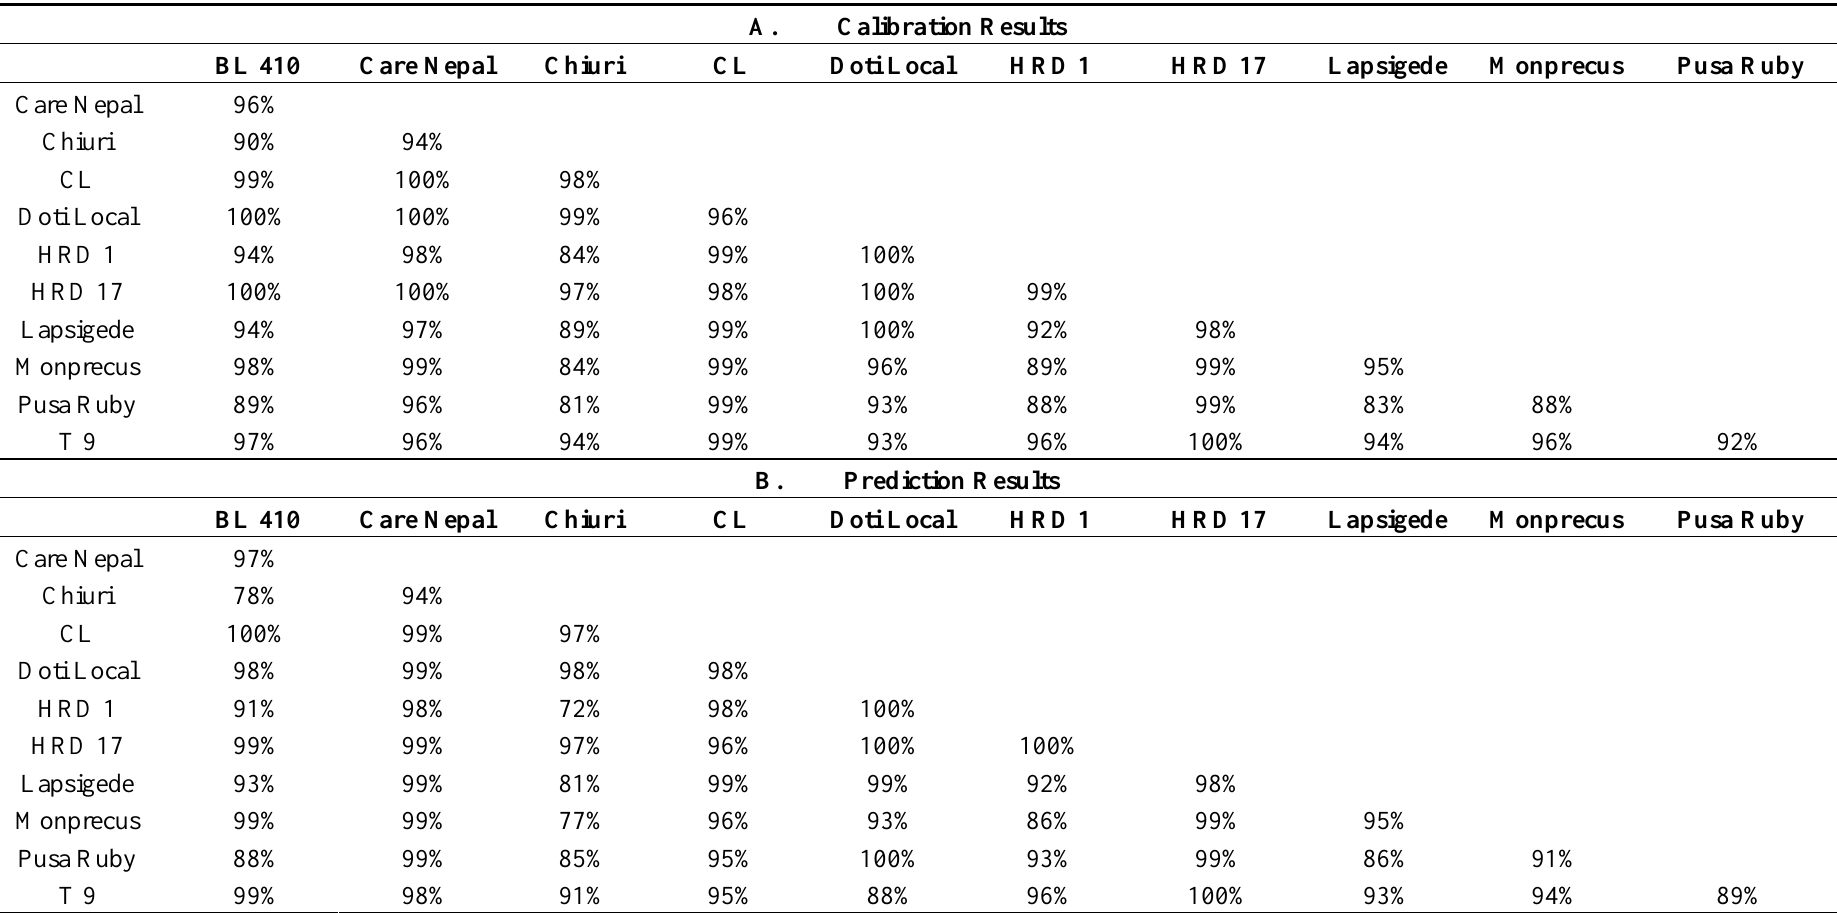
Table 3. Pairwise sensitivity of nCDA discrimination of Tomato cultivars (sensitivity- number of correctly classified seed samples in cultivar divided by the total number of samples in the